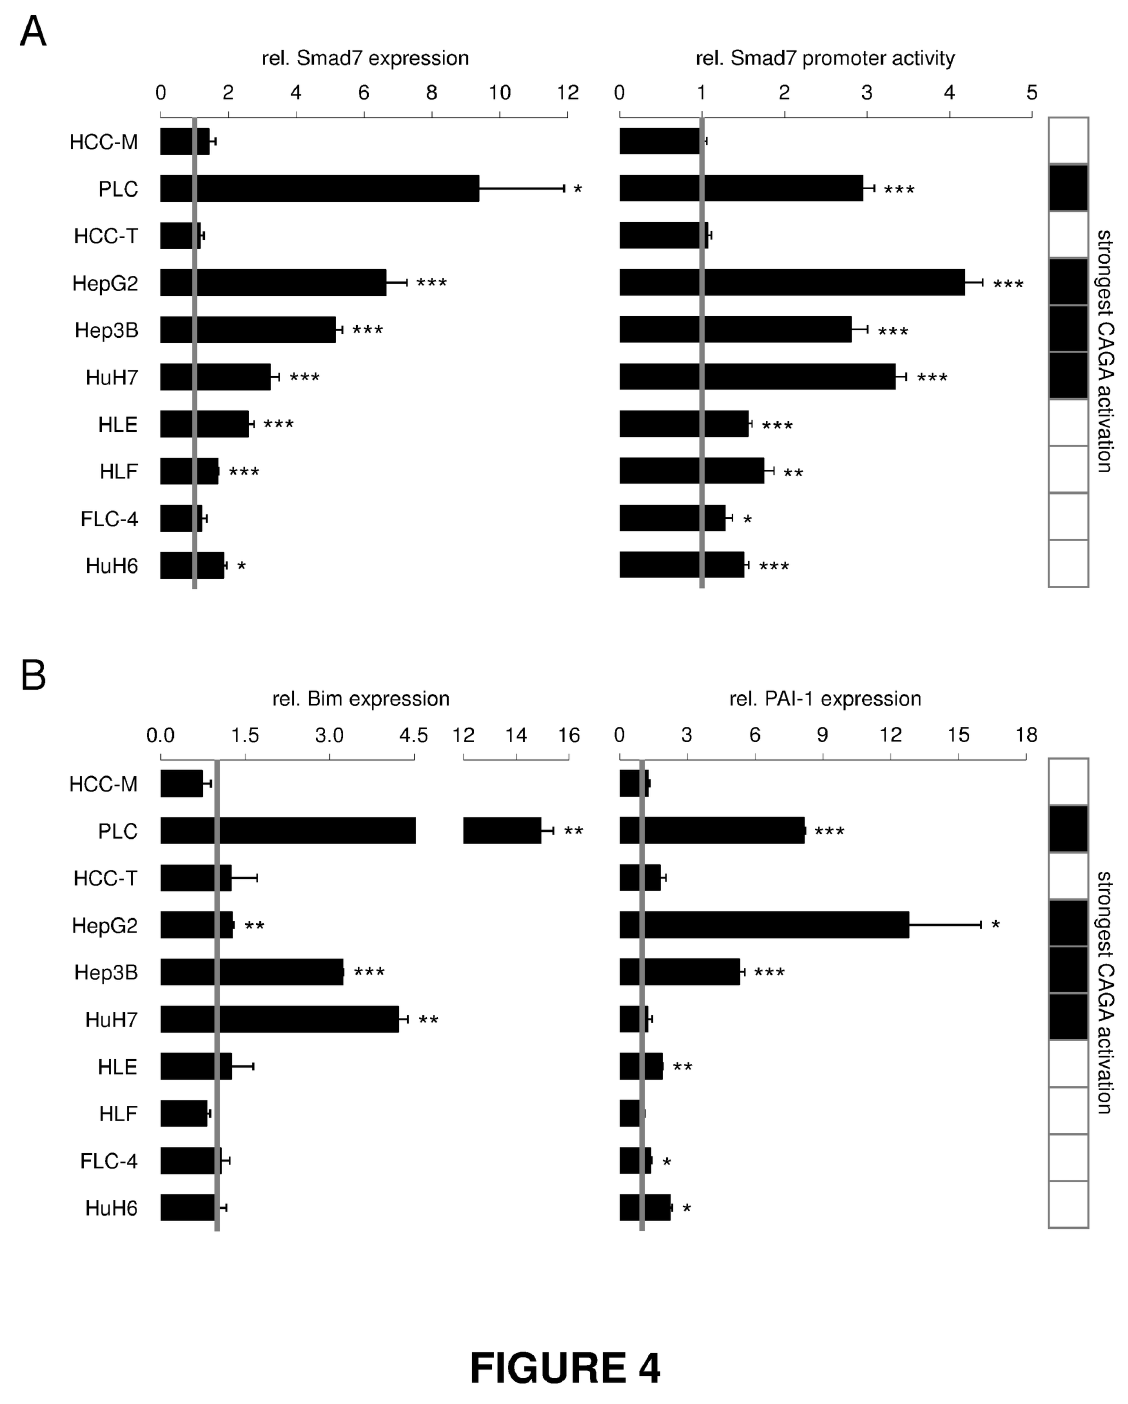
Figure 4. Induction of Smad7 expression by TGF-β correlates with cytostatic responsiveness. (A) Left side: Cells were treated with or without TGF-β for 2 h. Smad7 expression and 18S rRNA levels as reference gene were detected by real time PCR. Right side: For evaluation of transcriptional activity, HCC cell lines were transfected with a construct containing a luciferase gene under control of the Smad7-promotor and treated with TGF-β for 6 h. Treated samples were correlated to untreated controls. (B) Changes in expression levels of Smad3 target genes Bim and PAI-1 were detected after 2 h (PAI-1) or 24 h (Bim) using real time PCR analysis with rS18 as reference gene. The tables highlight cell lines with highest CAGA activity (black fields). Significant differences are indicated as * p < 0.05, ** p < 0.01 and *** p < 0.001 (Student’s t test). doi: 10.1371/journal.pone.0072252.g004 PLOS ONE |